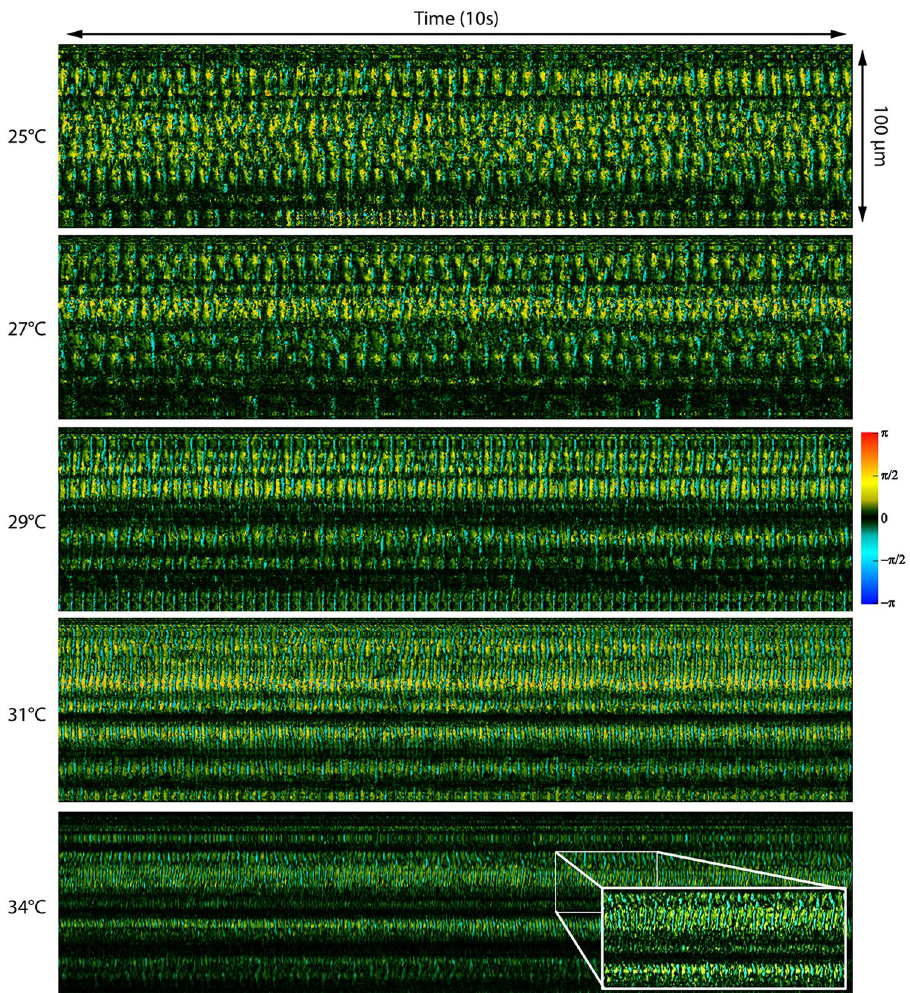
Figure 4. Doppler images of ciliary motion over time. Acquired at temperatures of 25 °C, 27 °C, 29 °C, 31 °C, and 34 °C. 10 seconds duration. Red/yellow represents periods of upward motion while blue/turquoise represents periods of downward